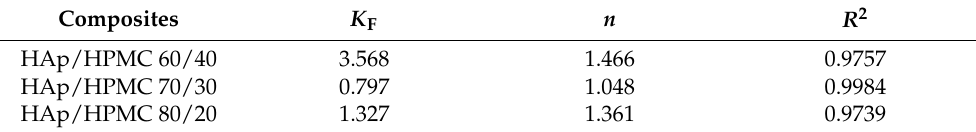
Table 4. Resultsusingthe Freundlich modeloftheMBadsorption isothermontheHAp/HPMCcomposite. Composites K F n R 2